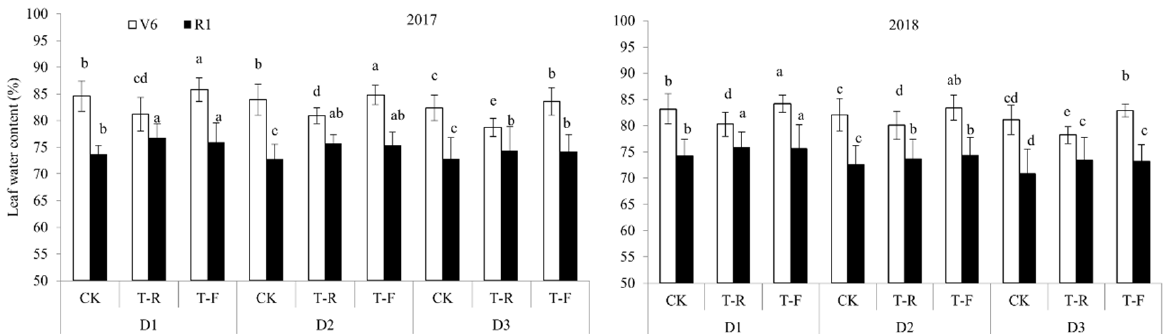
Figure 4. Leaf water content of maize under different planting patterns. At the same testing time, different letters above the bars indicate a significant difference between treatments at p < 0.05. D1, D2, and D3 represent maize were planted at 60,000, 75,000 and 90,000 plants ha − 1 , respectively. CK and T represent maize were planted in the conventional flat planting pattern and in the stereo-planting pattern, respectively. T-R and T-F represent maize were planted on the ridge and in the furrow, respectively. V6 and R1 represent six-leaf stage and silking stage, respectively. Vertical bar means the standard errors ( n = 3).